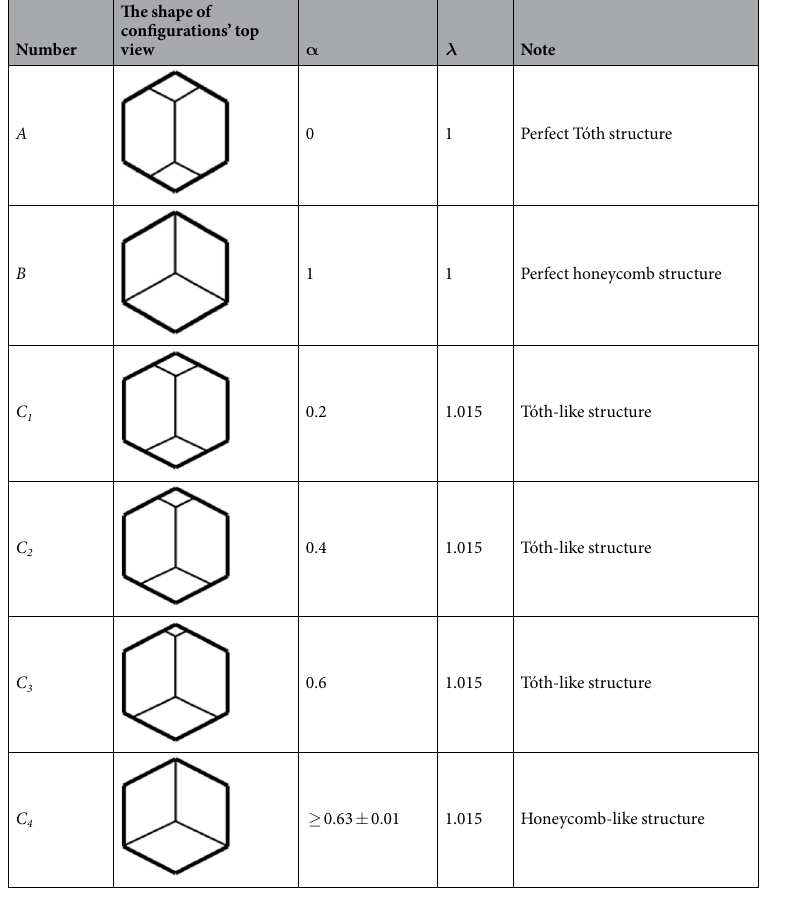
Table 2. The shapes and parameters of six points ( A , B , C 1 , C 2 , C 3 , C 4